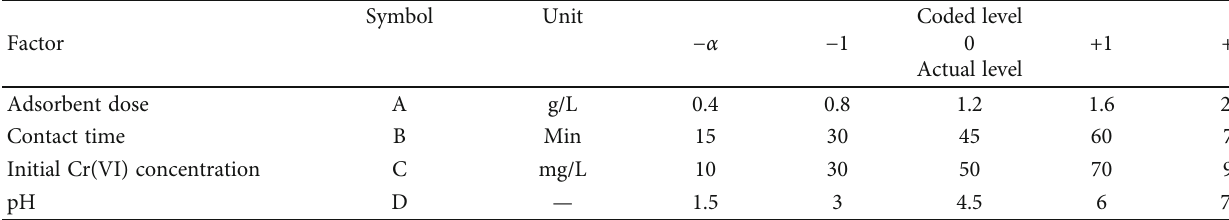
Table 2: The actual and coded levels of adsorption process